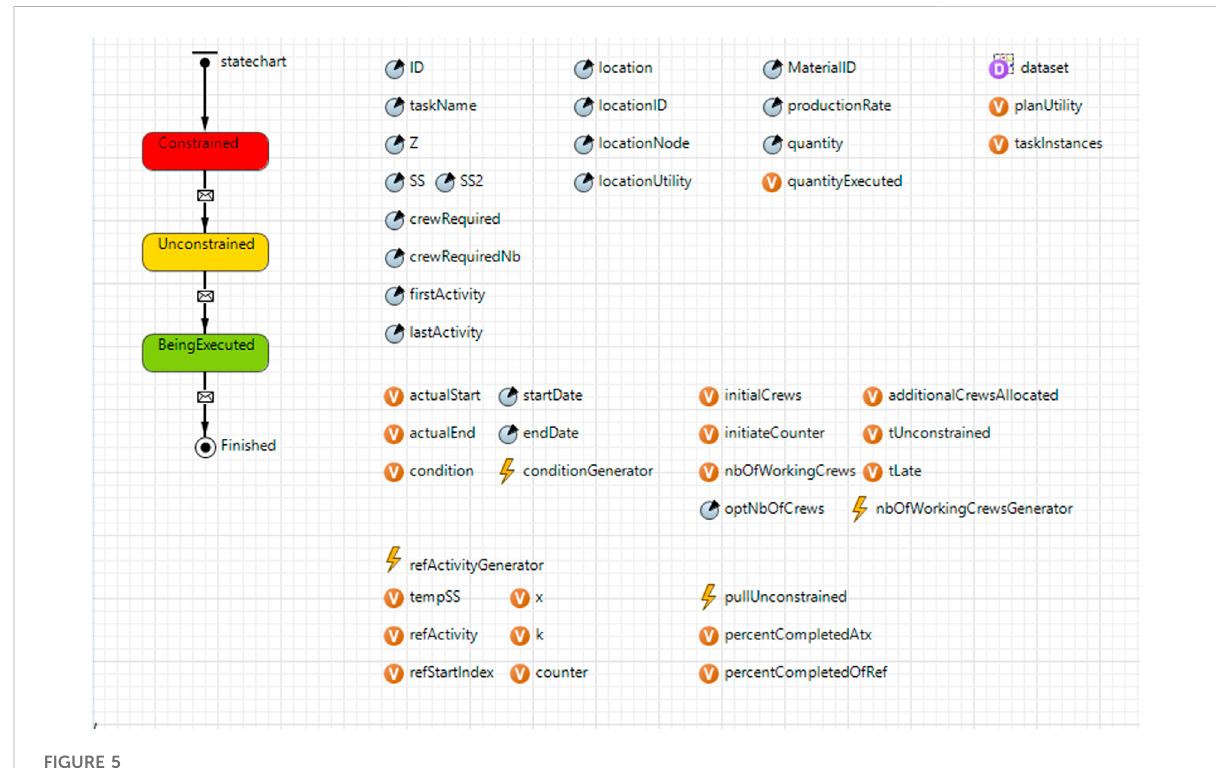
FIGURE 5 “ Activity ” agent